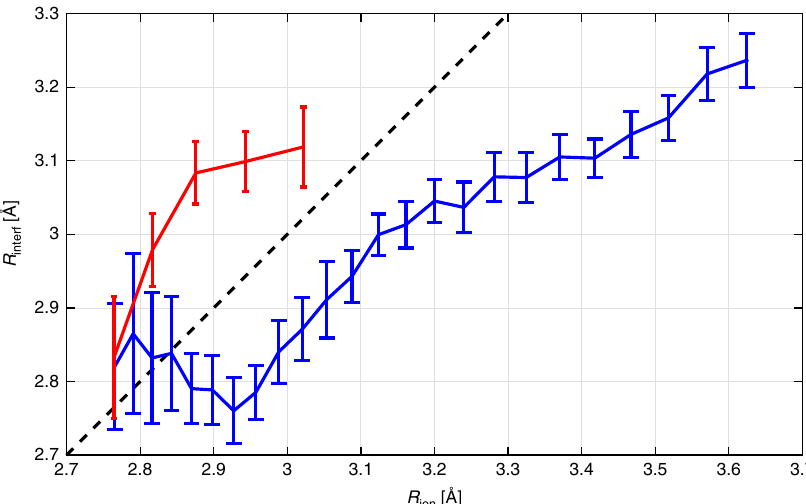
Fig. 5 Comparison of the two methods in determination of the bond length. R ion is the bond length of Ne 2 obtained from the ion momentum after the direct (blue) and indirect (red) fragmentations. R interf is the bond length obtained from the corresponding two-center interference pattern. Statistical error bars for the R interf correspond to the 1 σ con fi dence interval. The black dashed diagonal line visualizes the exact matching